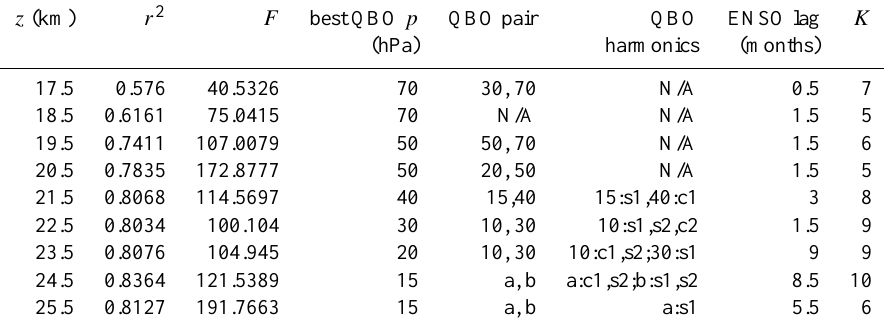
Table 1. Regression statistics versus altitude. The best single pressure for the QBO in terms of explaining variance is shown in the third column from the right. K is the number of basis functions. In the QBO harmonics column, c 1, s 1, c 2, and s 2 denote cosine and sine annual and semi-annual harmonics, respectively, and are preceded by the relevant QBO pressure. z (km) r 2 F best QBO p QBO pair QBO ENSO lag K (hPa) harmonics